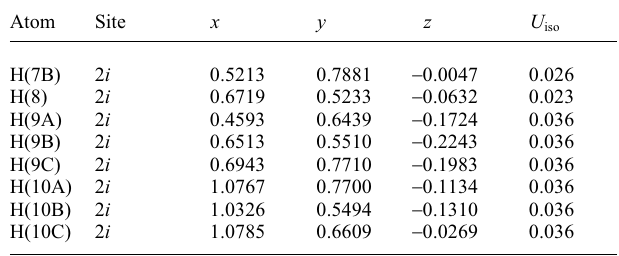
Table 3. Atomic coordinates and displacement parameters (in Å 2 ) .